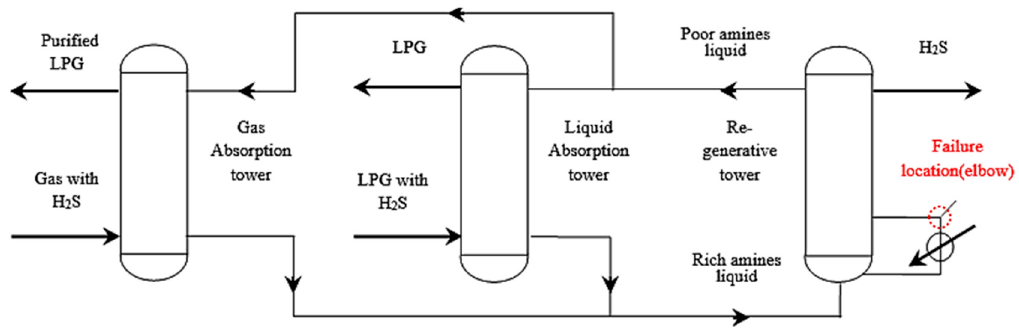
Figure 4. Desulfurization process and failure location. Table 1. The chemical components of the 20# steel.